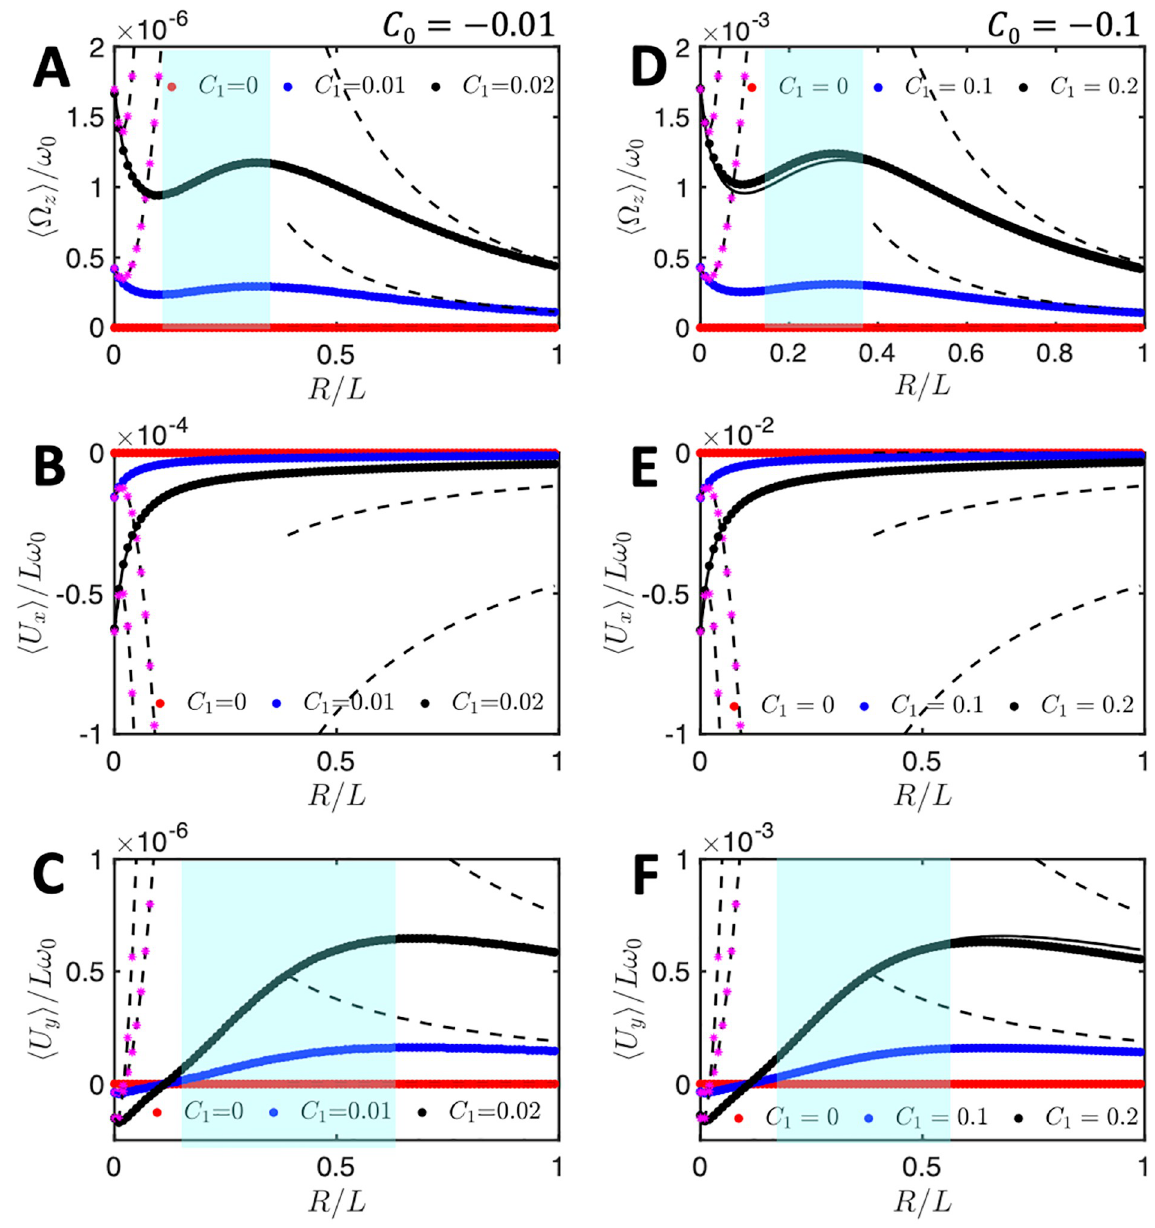
Fig 5. Anomalous flagella-based propulsion speed of a symmetrically attached bead as a function of its dimensionless radius r = R / L . Contrary to expectations, in the region highlighted in cyan, the mean translational and rotational velocities increase with increasing the bead radius. Analytical approximations (continuous lines calculated from Eqs 20–22) and simulations (dotted points) are performed at different values of C 1 , while the intrinsic curvature of the axoneme is fixed at C 0 = − 0.01 in (A-C), and C 0 = − 0.1 in (D-F). The black dashed curves show the trend expected in the limit of large bead radius ( r = R / L > 1), as presented in Eqs 26–28. The black dashed lines with stars in magenta illustrate the opposite limit of the small r , as given in Eqs